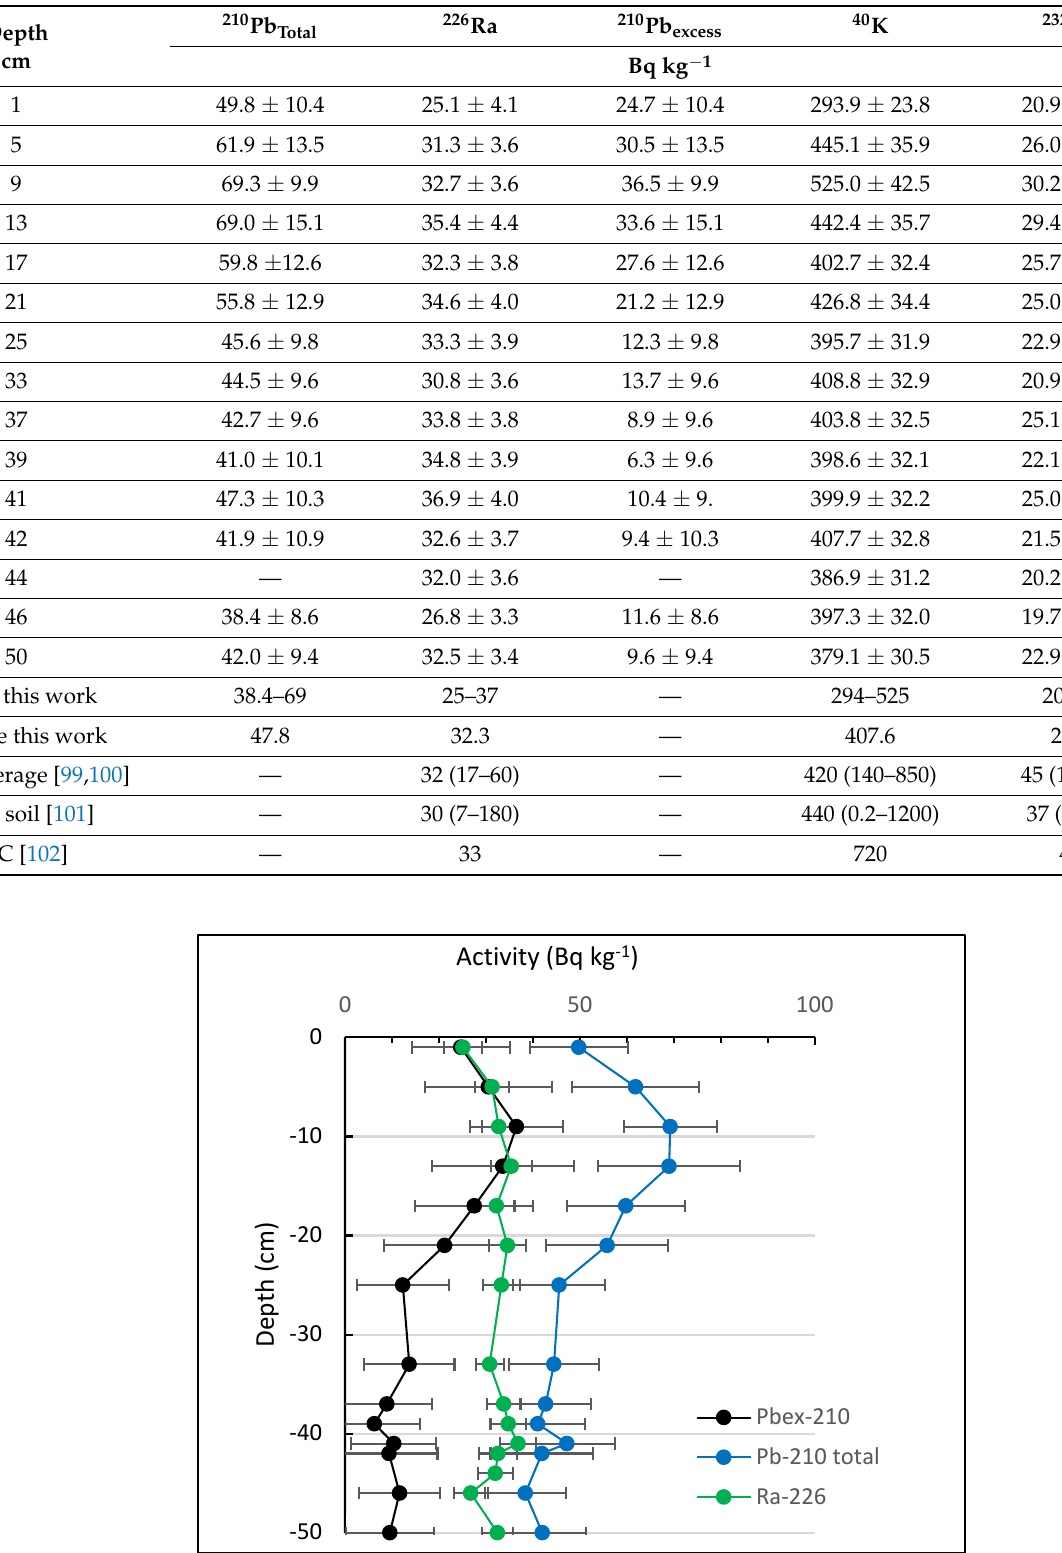
Table 3. Activity concentration in Bq kg − 1 in sediment core slices with uncertainties given as 1 σ and global average and ranges of natural background radiation concentration in soils.